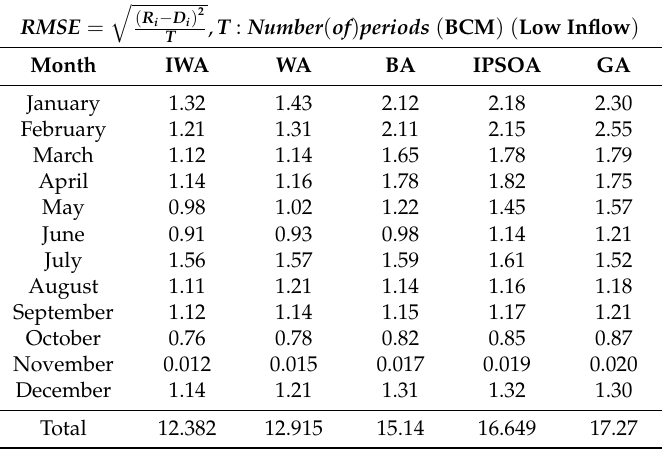
Figure 10. Released water for the total of operation periods. Table 9. Computed RMSE for low inflow.